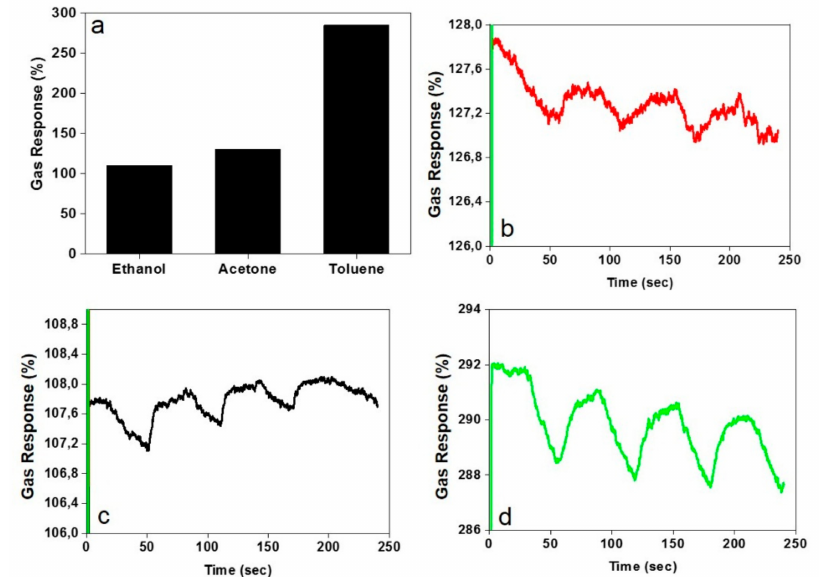
Figure 4. ( a ) Volatile organic compound (VOC) gas response of the a-CO x / G buckypapers; ( b – d ) the recovery property of the a-CO x / G buckypapers exposed to ethanol, acetone, and toluene,